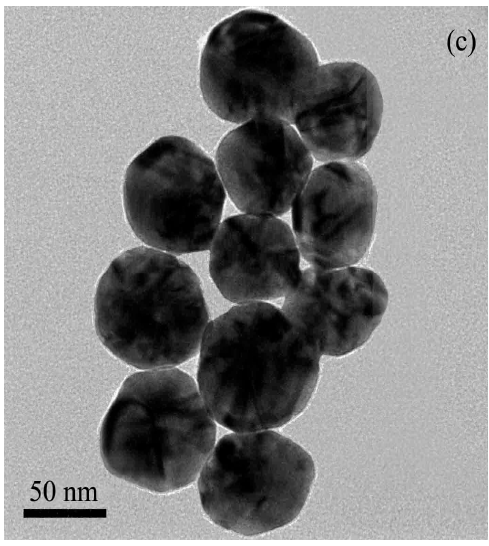
Figure 3. Transmission electron microscopy images of Au@Ag NPs synthesized with different amounts of Au seeds including ( a ) 0.4 mL; ( b ) 0.5 mL and ( c ) 0.9 mL. Compared with SERS spectra of the concentration of 1 and 0.1 mg/L flusilazole, there could not be detected by conventional Raman (Figure 4a), while the SERS intensities of flusilazole were largely affected by the sizes of Au@Ag NPs. As shown in Figure 4a,b, Au@Ag NPs of 90 ± 7 nm led to the best SERS enhancement effect, particularly for 0.1 mg/L concentration. Therefore, the 90 ± 7 nm Au@Ag NPs was used for following experiments for the analysis of flusilazole.